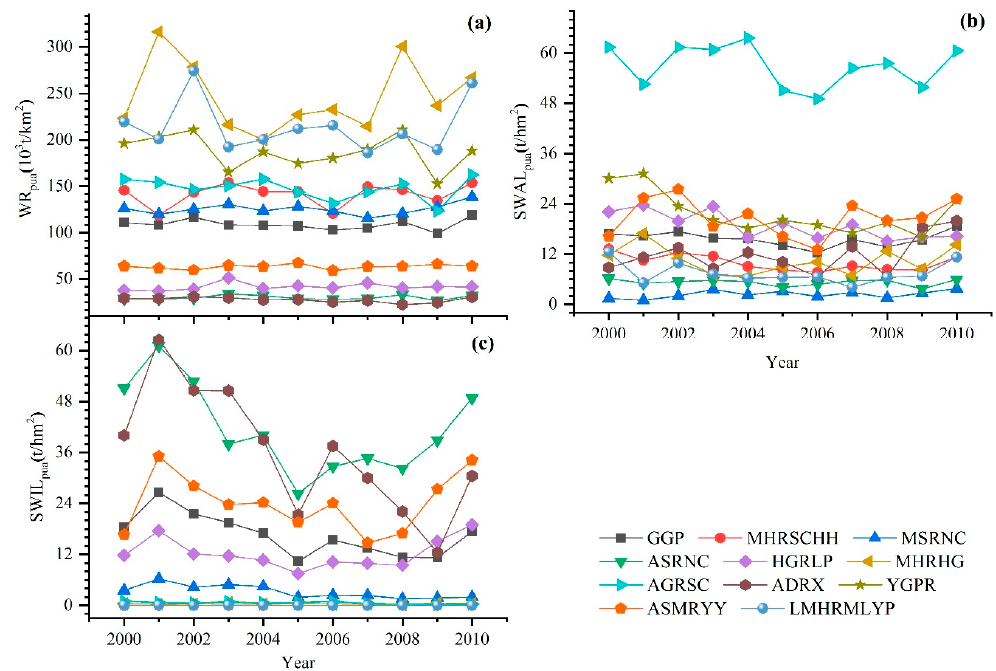
Figure 7. Temporal trends of annual ecosystem services (ESs) changes in the Grain for Green Program (GGP) area from 2000 to 2010. ( a ), ( b ), and ( c ) are the temporal trends of annual WR pua , SWAL pua , and SWIL pua changes, respectively. Table 6. Statistical parameters of ecosystem services indicators in the Grain for Green Program (GGP) area from 2000 to 2010. The units of the mean and slope of WR pua are 10 4 t km -2 and 10 4 t km -2 yr -1 , respectively, while for both SWAL pua and SWIL pua , units are t ha and t ha yr -1 , respectively. Ecosystem services